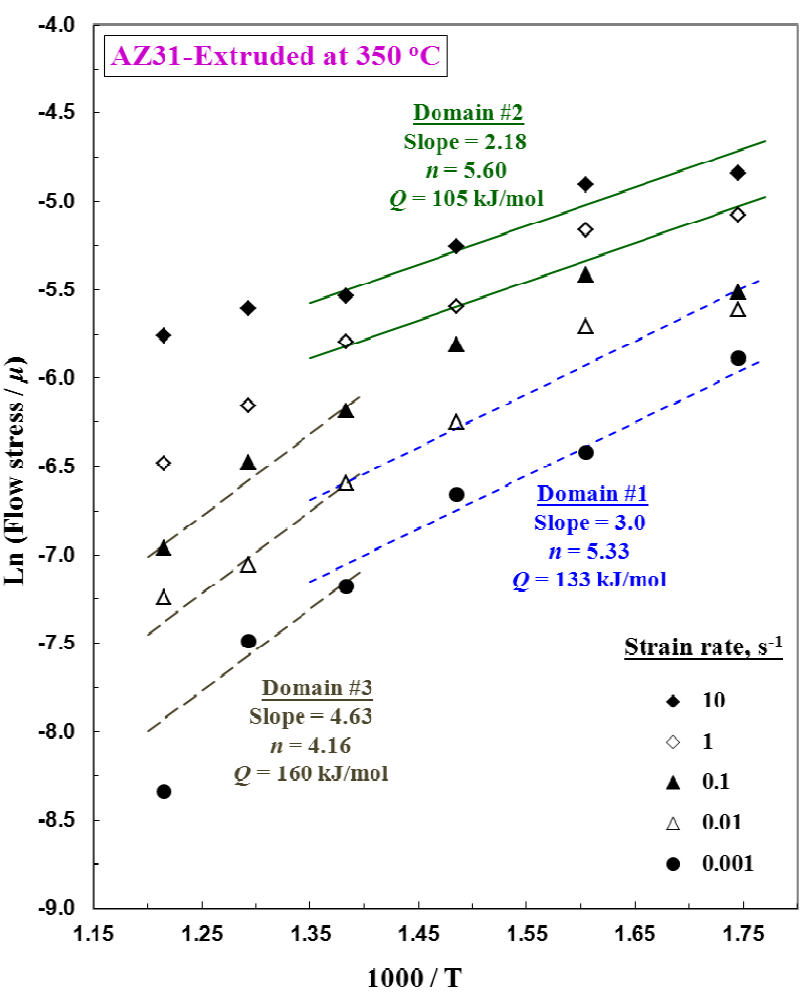
Figure 10. Arrhenius plot for calculating apparent activation energy in the three domains of processing map for AZ31 magnesium alloy extruded at 350